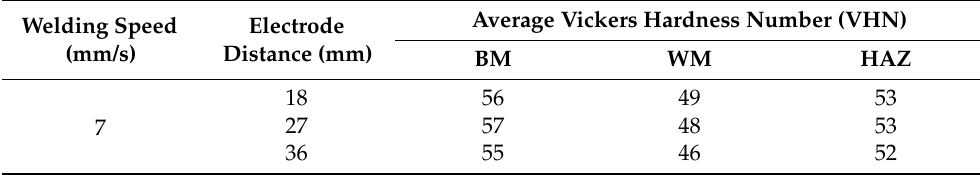
Table 2. Average Vickers Hardness Number (VHN) of tandem MIG welding.